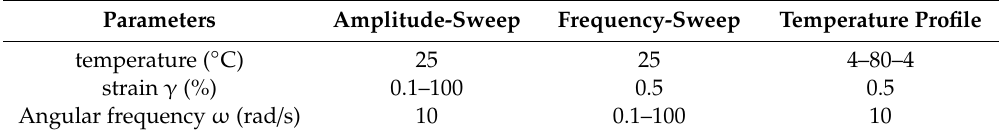
Table 1. Experimental parameters for the rheological experiments.